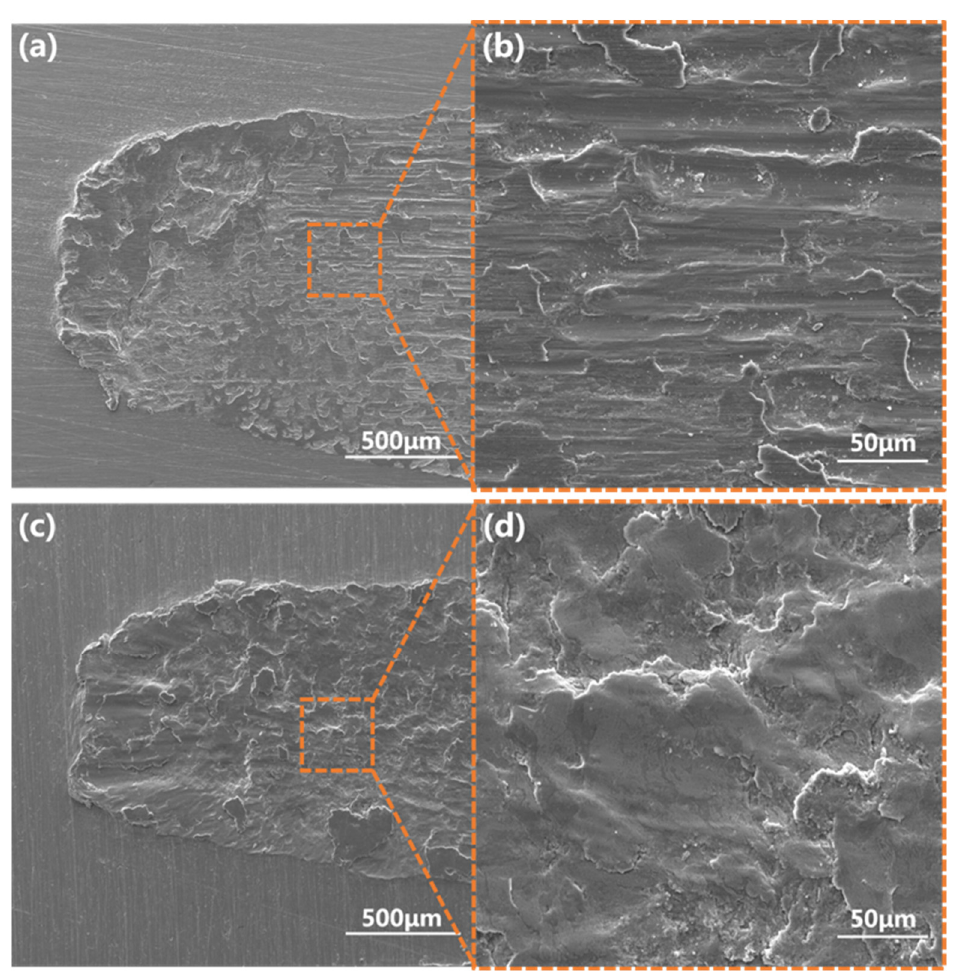
Figure 11. Morphologies of ( a , b ) T9 steel substrate and ( c , d ) SPCC steel after wearing.